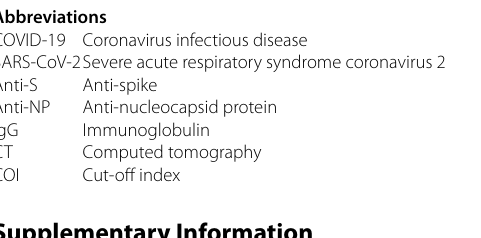
Table S2. SARS-CoV-2 anti-spike (ratio) in relation to demographic data and risk factors of 92 COVID-19 home-isolated patients. Acknowledgements Not